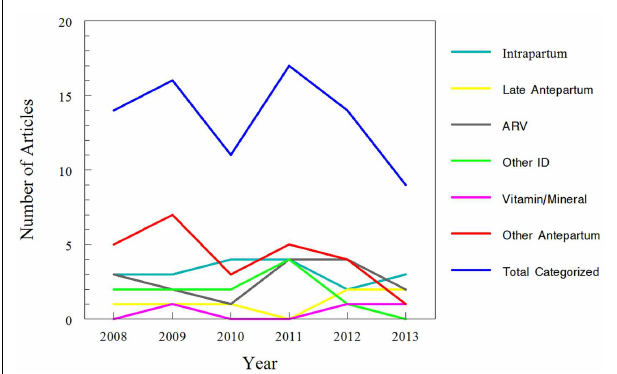
FIGURE 4 |Trends for classification of search results for recent clinical trials of pharmacokinetics and pregnancy . Data for 2013 only